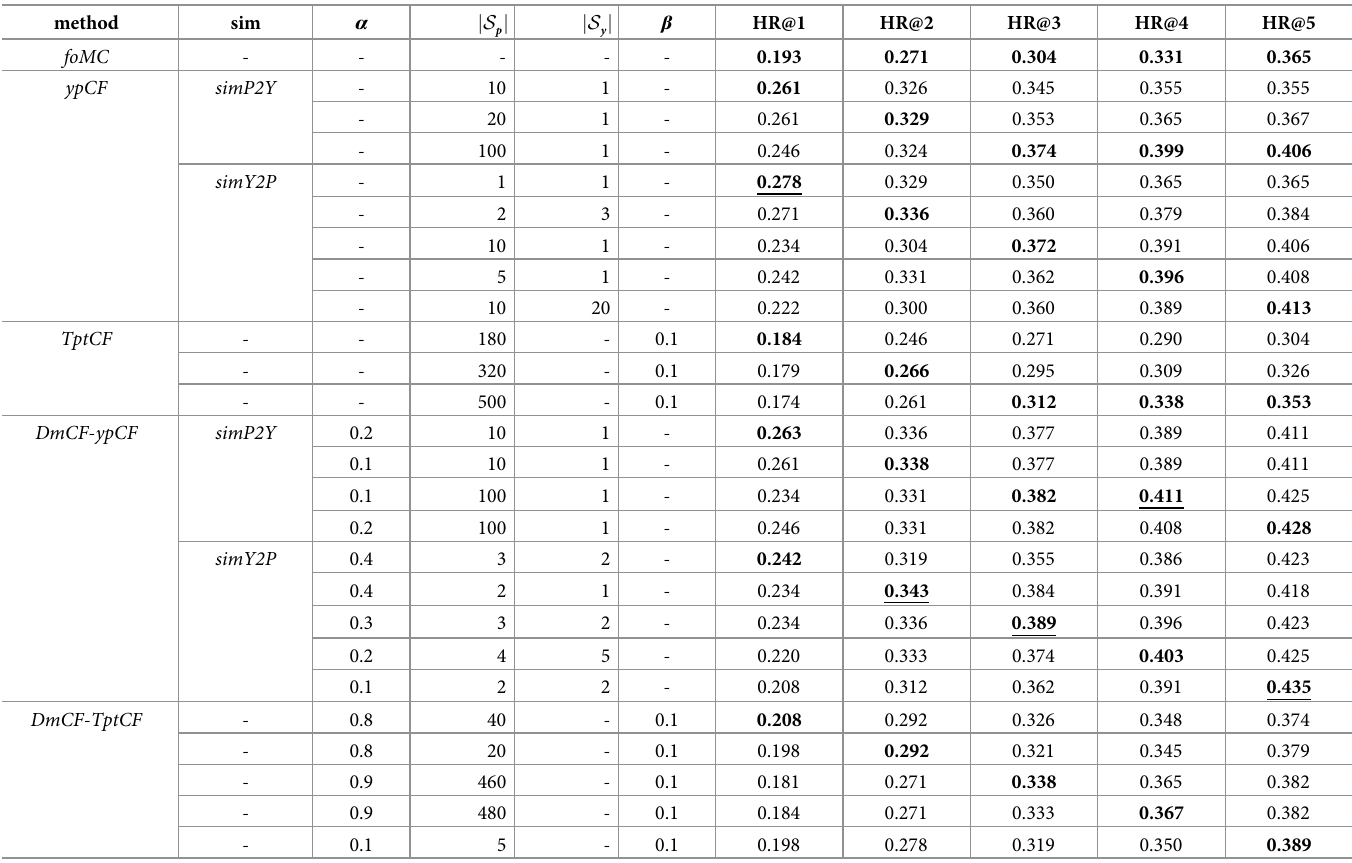
Table 8. Overall performance of all methods for CUTOFF 09/03/2013. method